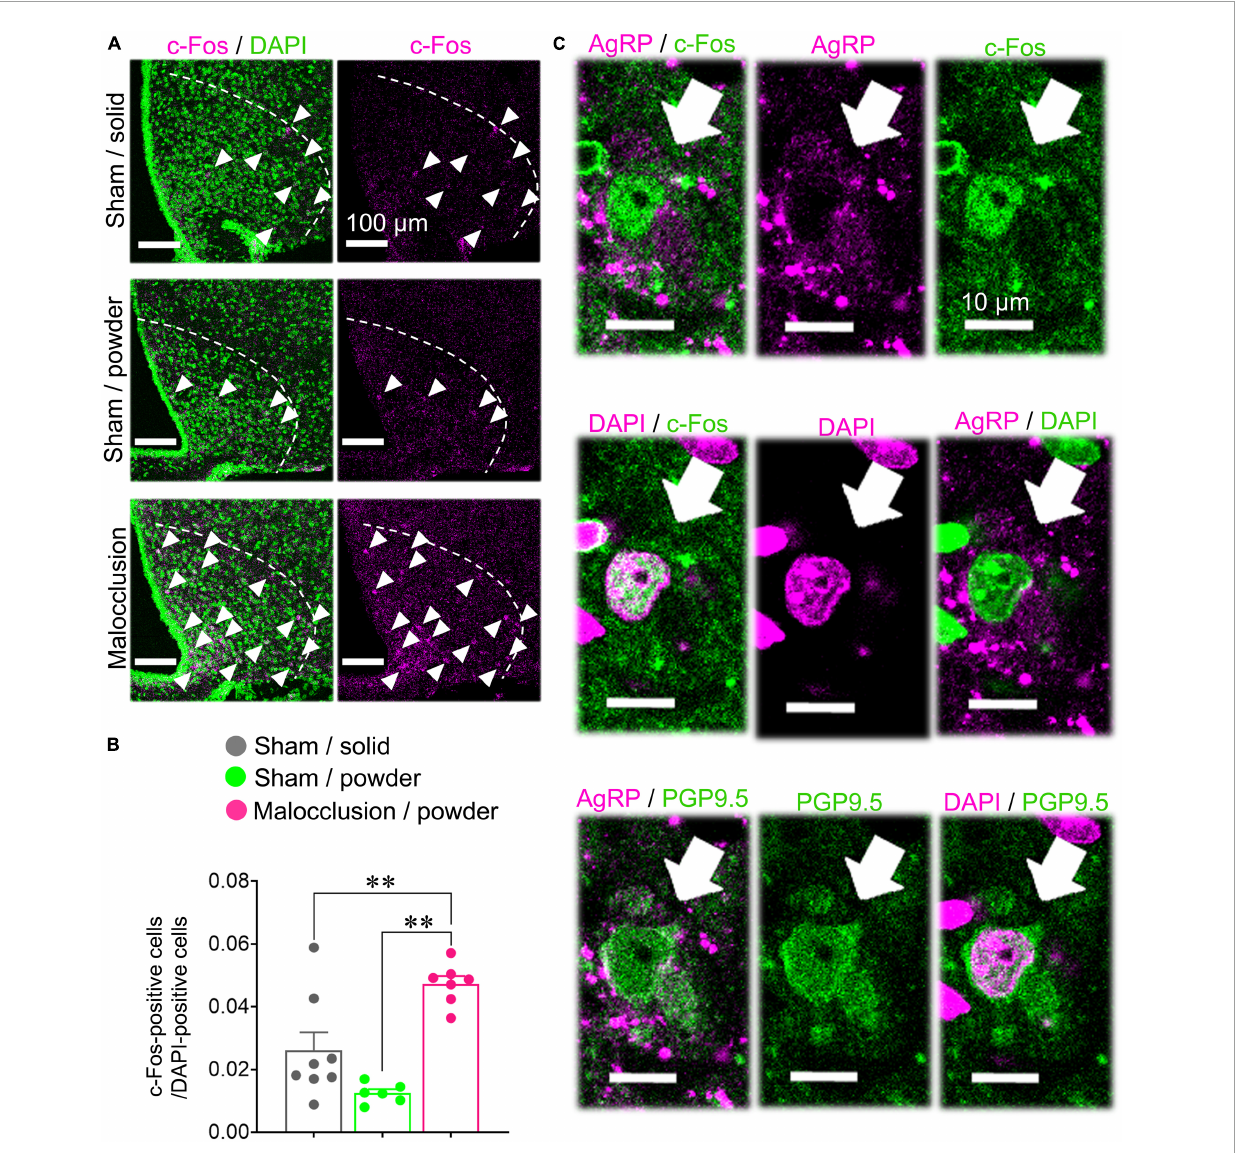
FIGURE4 Immunostaining for c-Fos and AgRP. Coronal sections of arcuate nuclei were stained with anti-mouse c-Fos and/or anti-AgRP antibody. (A) Representative images of c-Fos-positive cells (white arrowheads) in arcuate nucleus (white dashed line) when subjected to immunofluorescent staining. (B) c-Fos-positive cells were enumerated on one side of each of the six hypothalamus tissue sections per mouse in Sham/solid ( n = 8), Sham/powder ( n = 6), and Malocclusion/powder group ( n = 7). The numbers of c-Fos-positive cells were normalized by DAPI-positive cells. Data are represented as means ± SEM. Differences were considered significant at ** p < 0.01. (C) Representative images of AgRP- and c- Fos-, DAPI- and c- Fos-, AgRP- and DAPI-, AgRP- and PGP9. 5-, and DAPI- and PGP9.5-positive cells in arcuate nuclei subjected to immunofluorescent staining (white